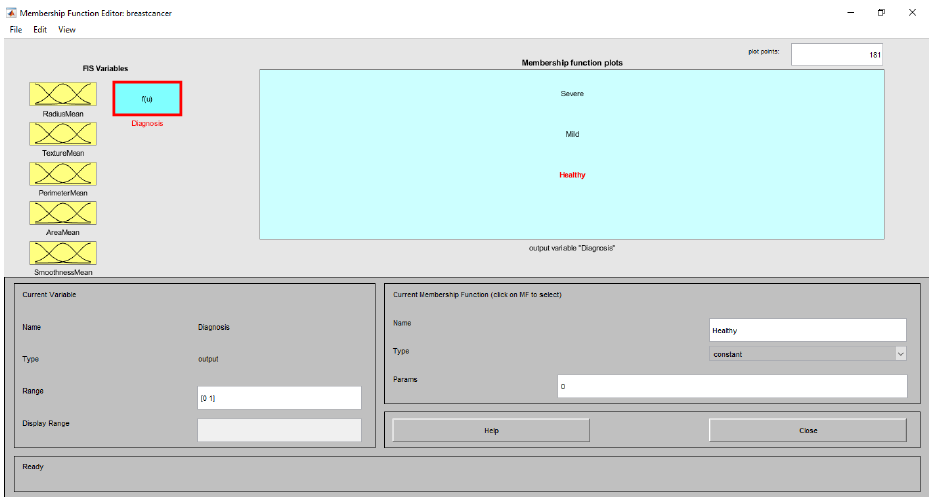
Figure 19. Membership functions of the linguistic variables output feature.